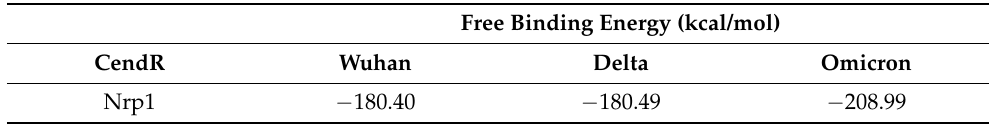
Table 1. Determination of free binding energy (kcal/mol) from the docking analysis of Omicron, Delta, and Wuhan variant CendR with